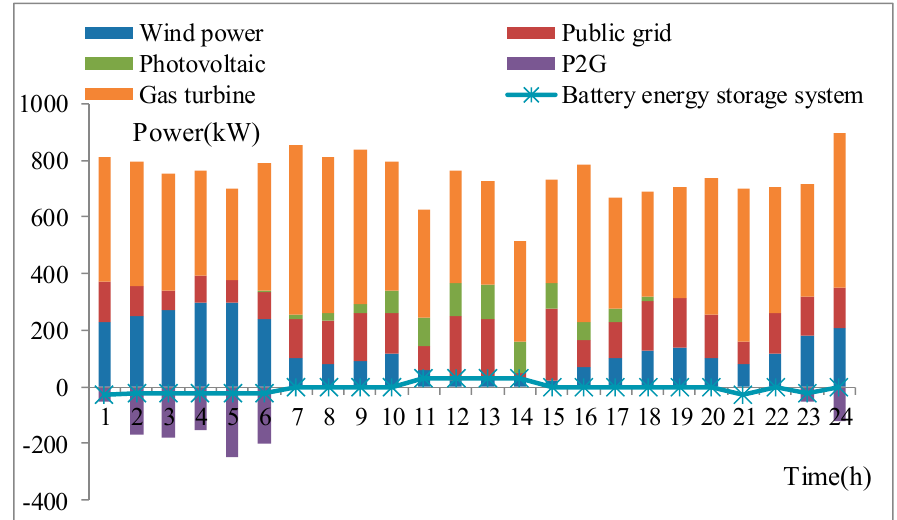
Figure 6. The output structure of each device in Scenario 4. Table 4. The cost of the system in different scenarios.